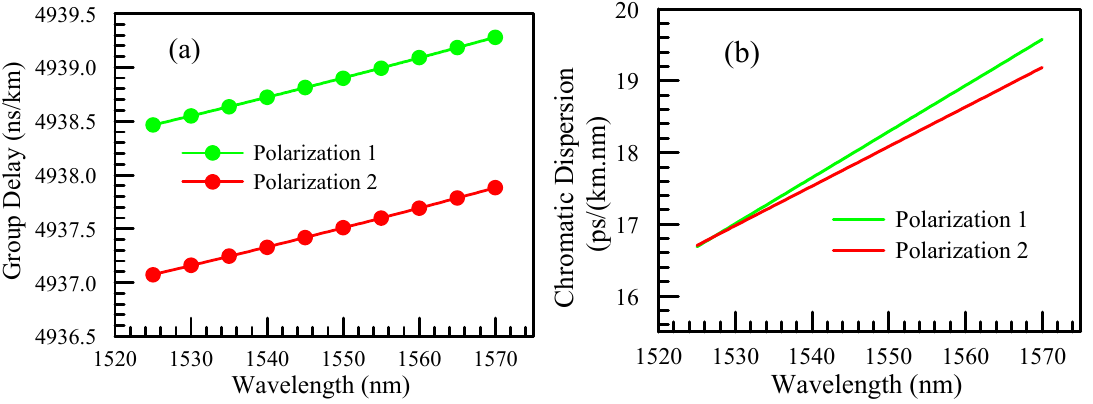
Figure 5. ( a ) Group delay as a function of wavelength for PMF around 1550 nm; ( b ) chromatic dispersion as a function of wavelength for PMF around 1550 nm.